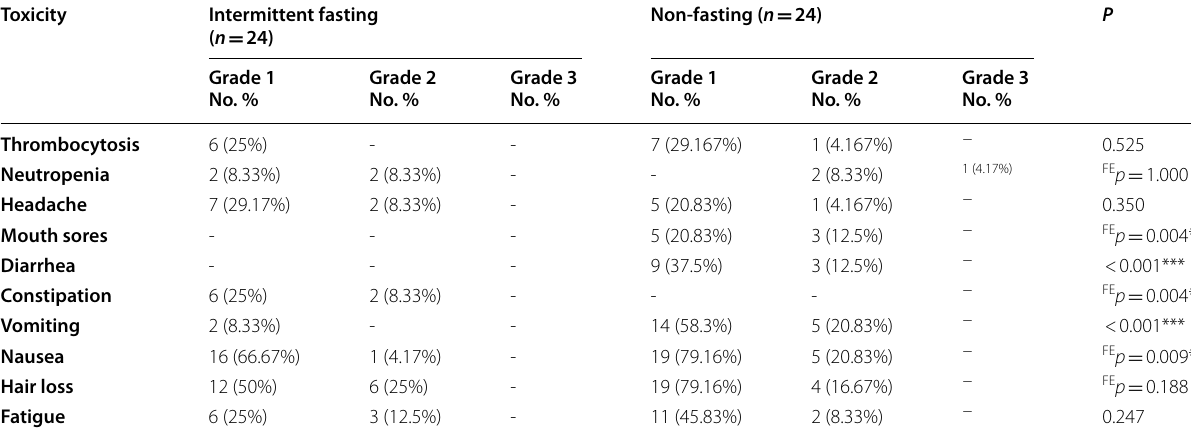
FE Fisher exact. P P -value for comparing between intermittent fasting and non-fasting group * P < 0.05 ** P < 0.01